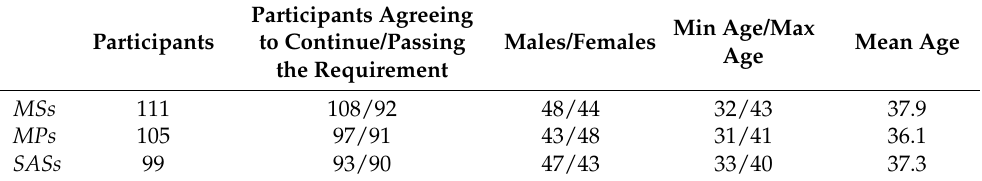
Table 1. Characteristics of the participants in the study and the final involvement.